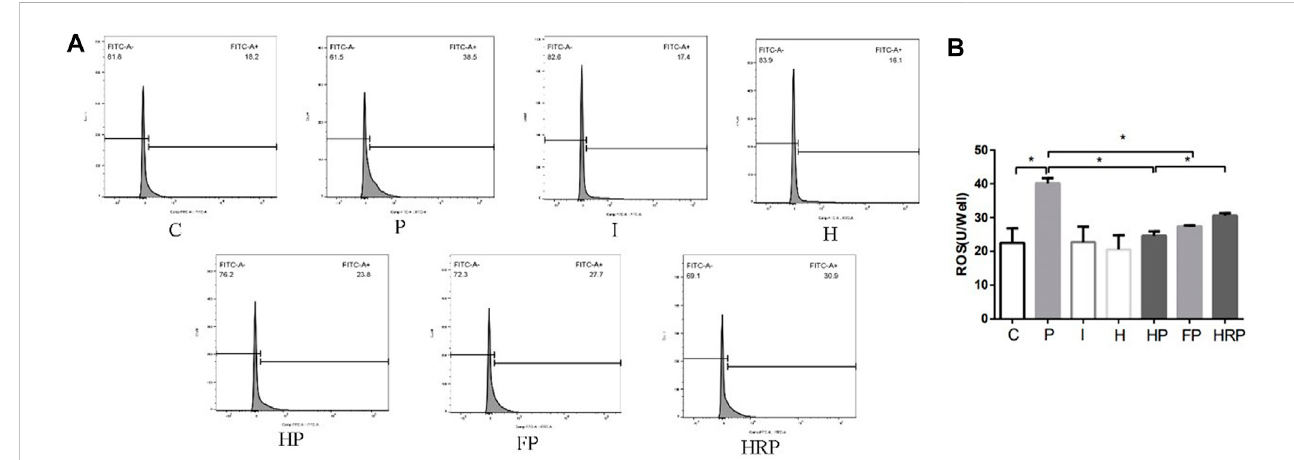
FIGURE 7 ChangesinROSinprimaryhippocampalneuronsexposedtopropofolwithorwithouthypoxicpreconditioning,inhibitororagonist. (A,B) ROScontentin each group (one-way ANOVA, * p <